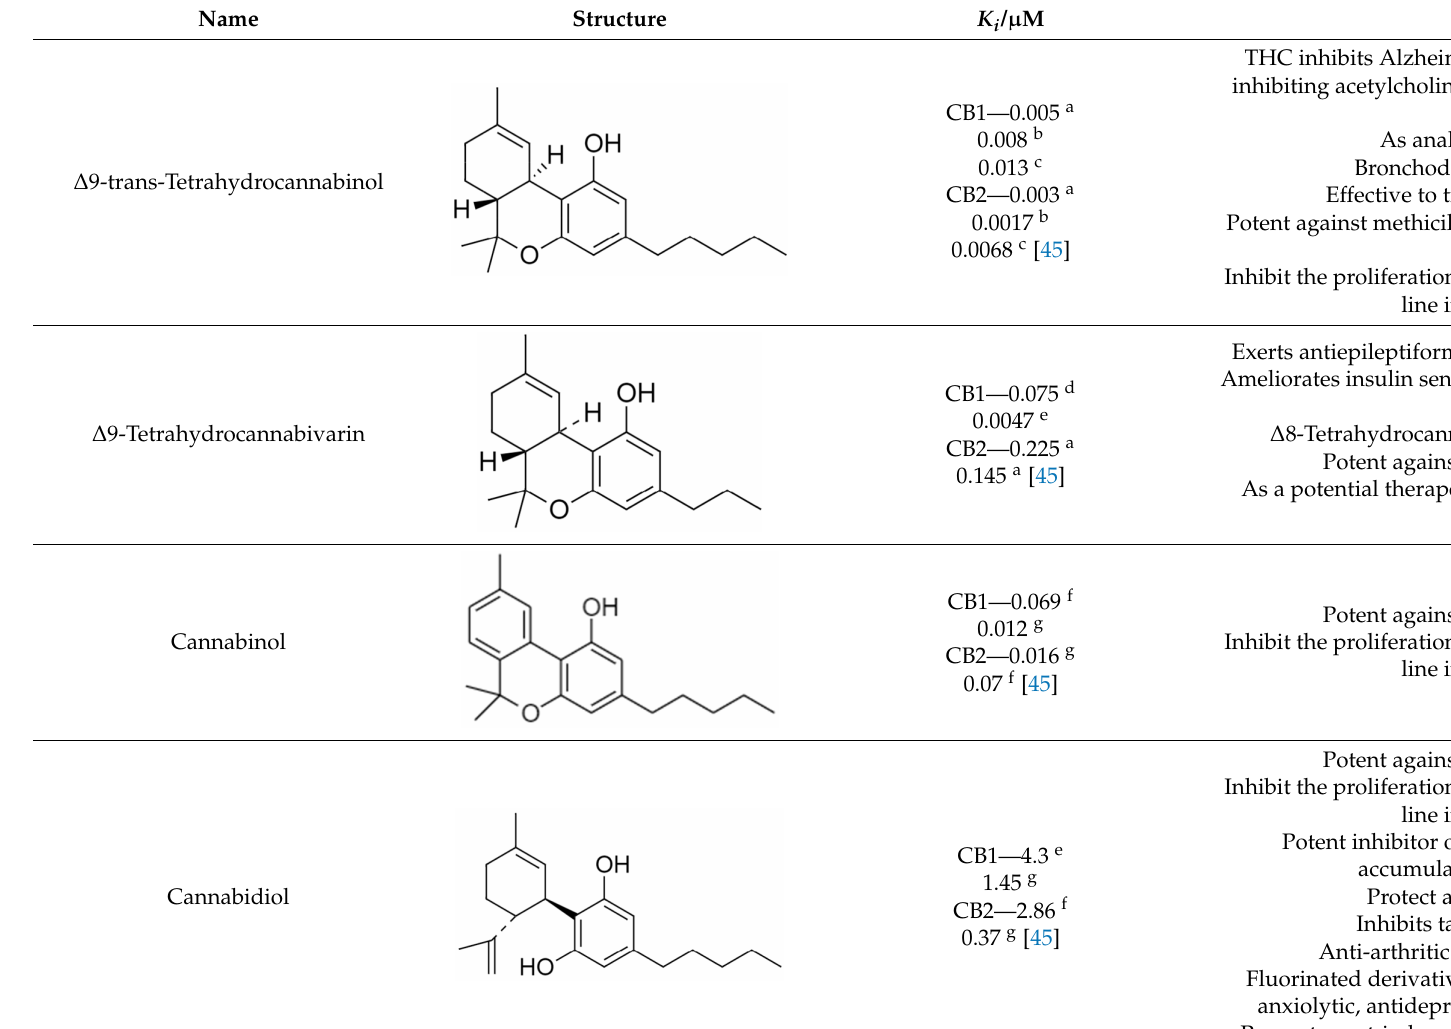
Table 1. List of phytocannabinoids with their structures, K i , and key